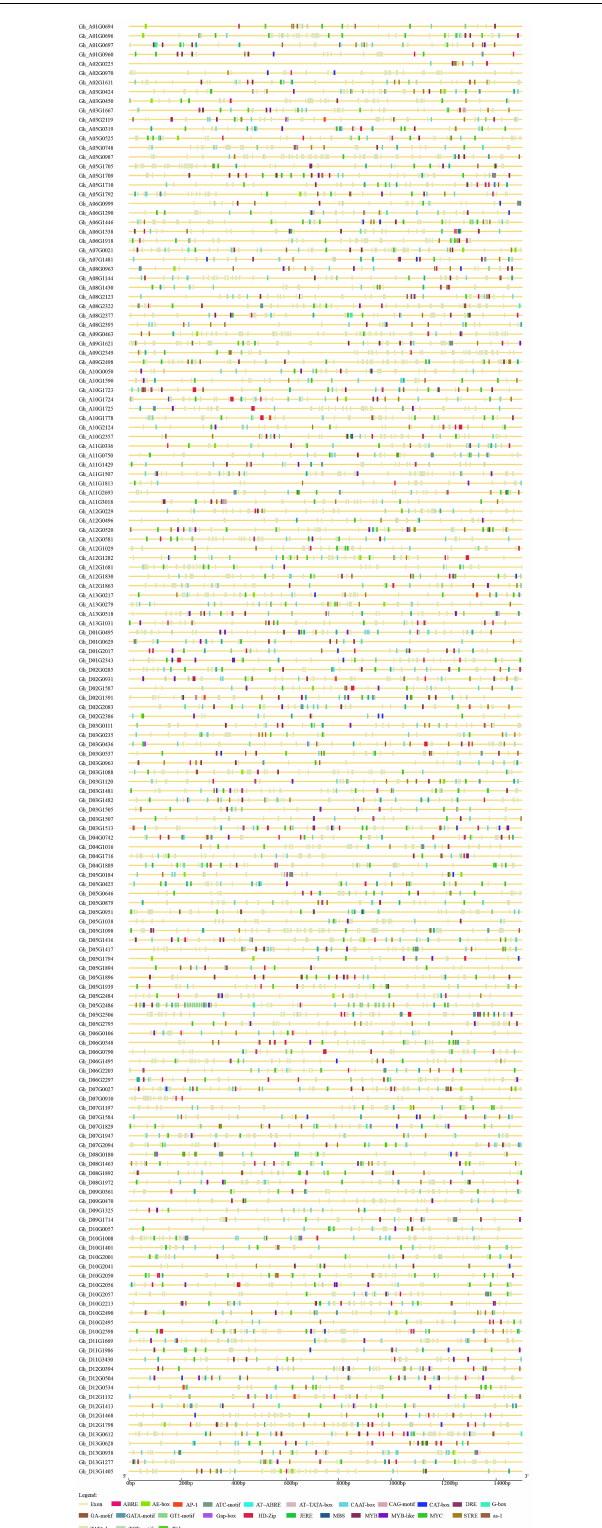
FIGURE 3 | Upstream cis- acting elements of the P450 family genes in upland cotton.